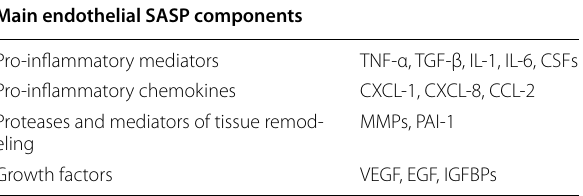
Table 1 Main endothelial SASP